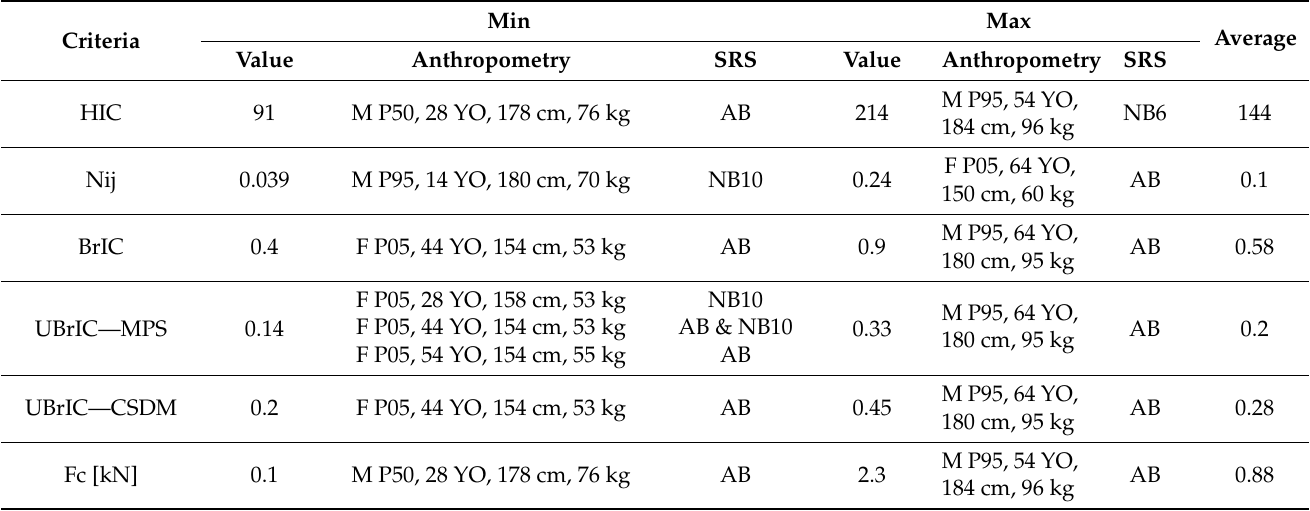
Table 3. Summary of the extreme values of the particular criteria for 30 km/h.